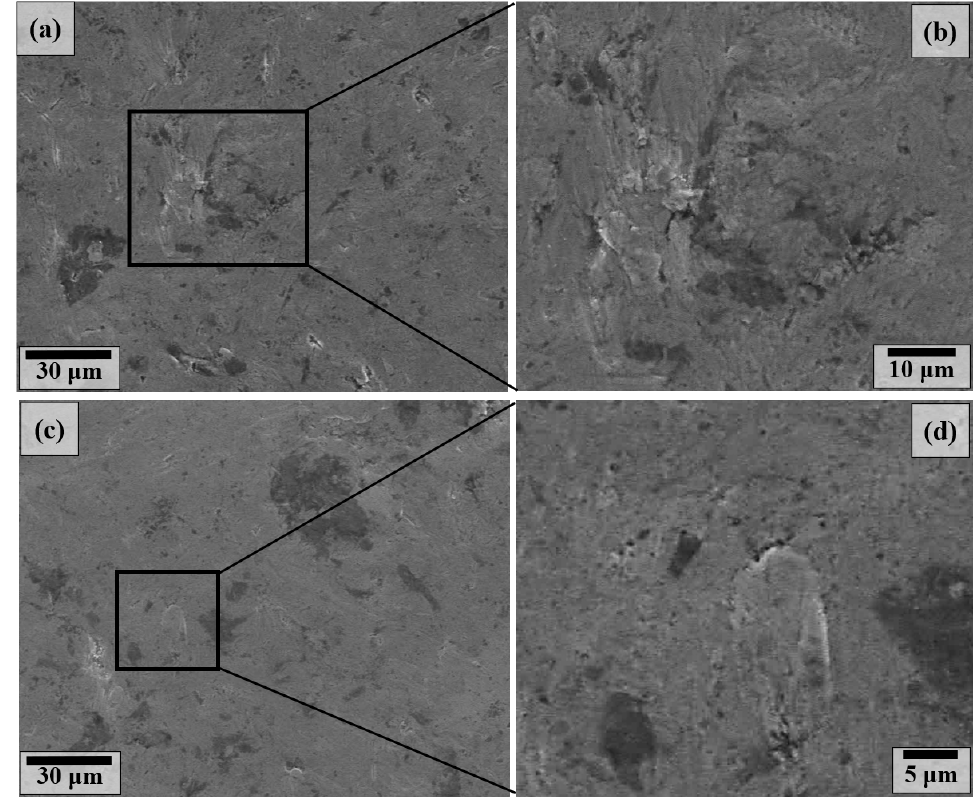
Figure 6. SEM images of shot-peened Cp-Ti surface at low magnification ( a , c ) and at high magnification ( b , d ).